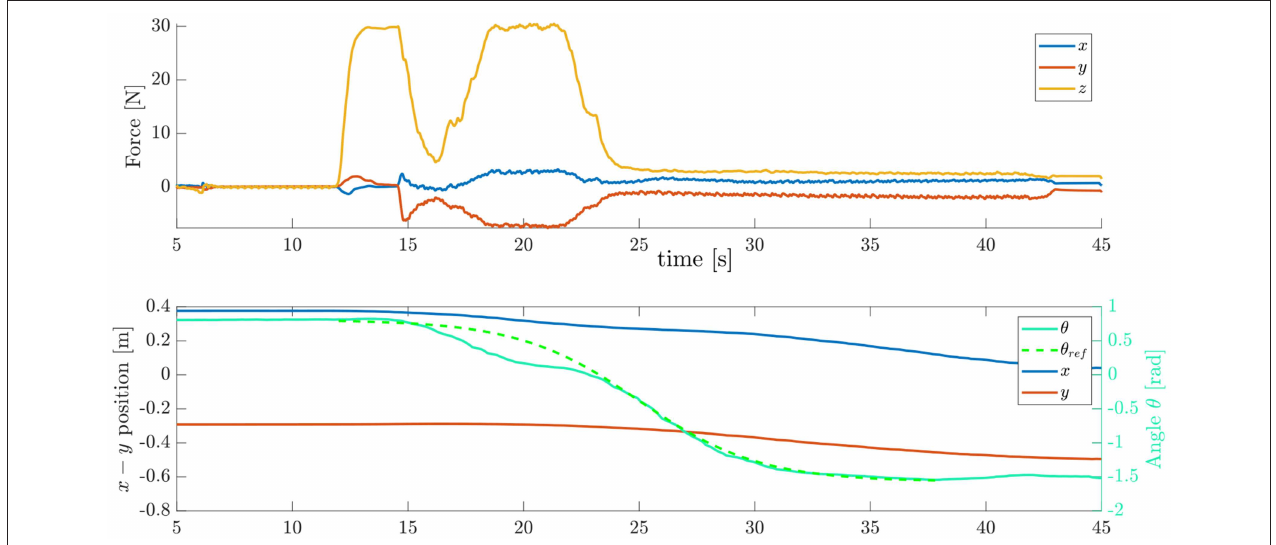
FIGURE 8 | Strategy 2 Pivot and Re-Grasp. (Above) Forces applied by the controller. (Below) Object